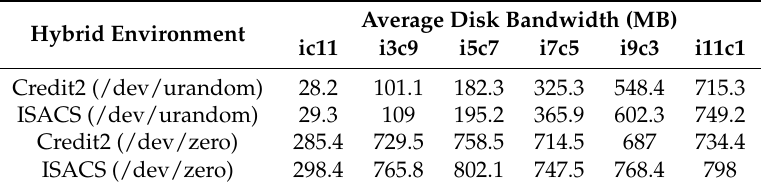
Table 7. Average disk bandwidth according to the VM configuration based on Figure 11.